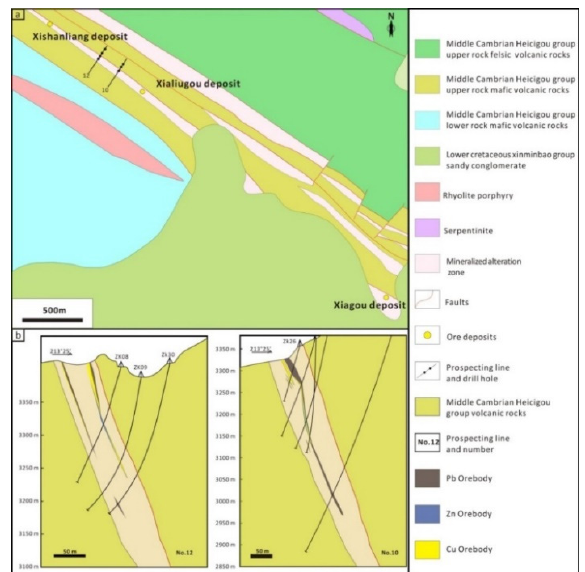
Figure 2. Simplified geological map ( a ) and cross-sectional map of line No.10 (right) and No.12 (left) in the Xialiugou deposit ( b ), m = modified from reference [25].